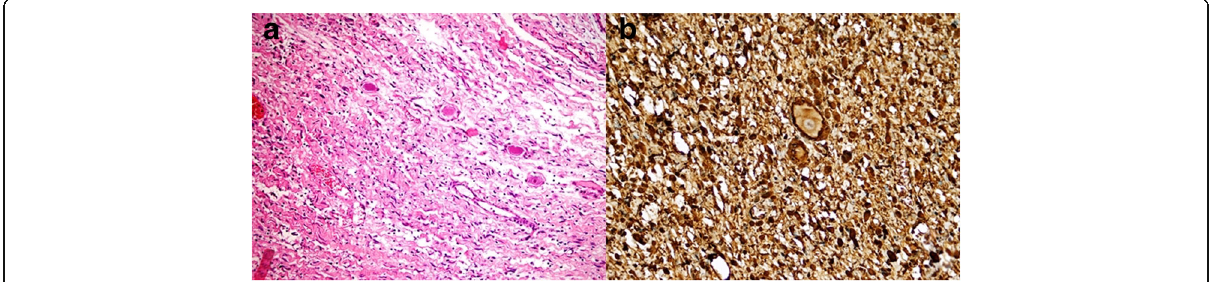
Fig. 3 a Admixture of ganglion cells and Schwann cells (hematoxylin and eosin staining, × 10). b Admixture of ganglion cells and Schwann cells (S100 staining, ×